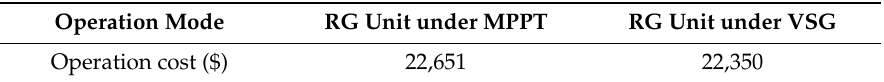
Table 7. Total operation cost.